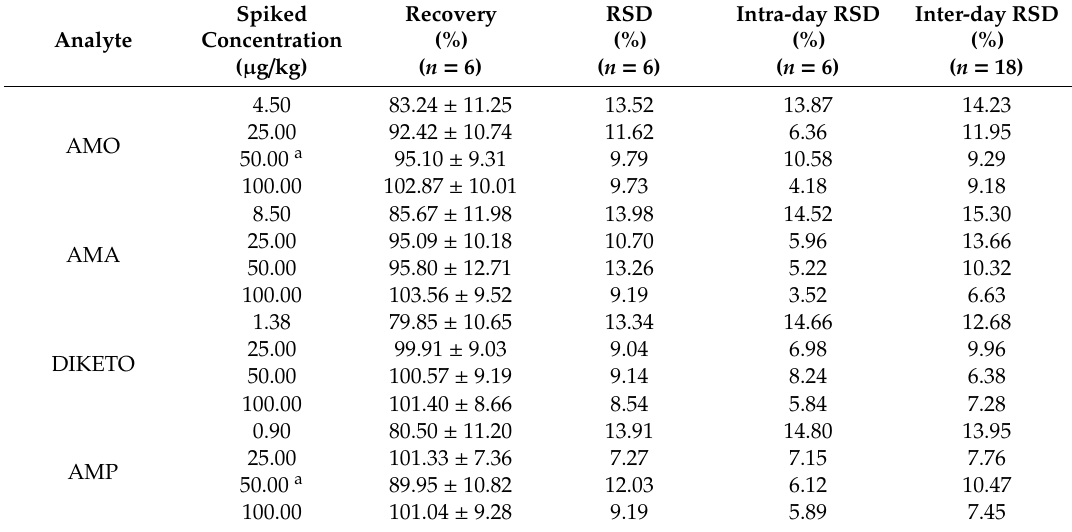
Table 7. Recoveries from and precision of the analysis of AMO, AMA, DIKETO, and AMP spiked in blank kidney